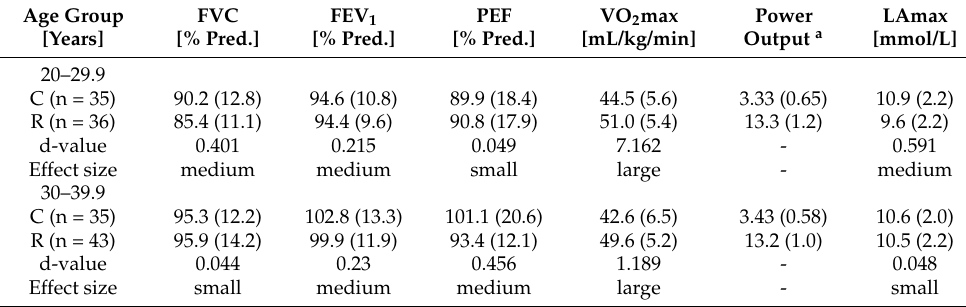
Table 4. Pulmonary function (FVC forced vital capacity; FEV 1 . forced expiratory volume in 1 s; PEF peak expiratory flow) and performance characteristics in female recreational cyclists (C) and runners